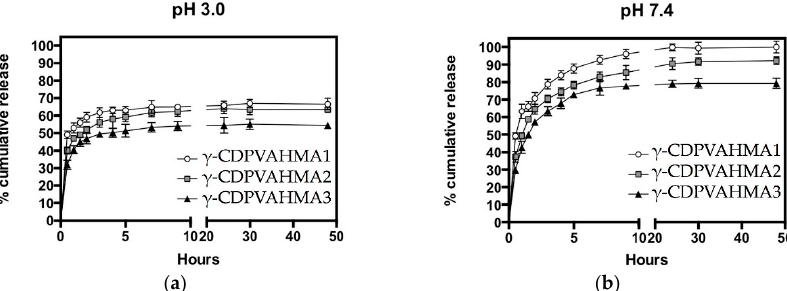
Figure 8. NFD release profile from γ -CDPVAHMA formulations in two model solutions, pH 7.4 and pH 3.0: ( a ) cumulative release from γ -CDPVAHMA1, − 2, and − 3 at pH 3.0; and ( b ) cumulative release from γ -CDPVAHMA1, − 2, and − 3 at pH 7.4.